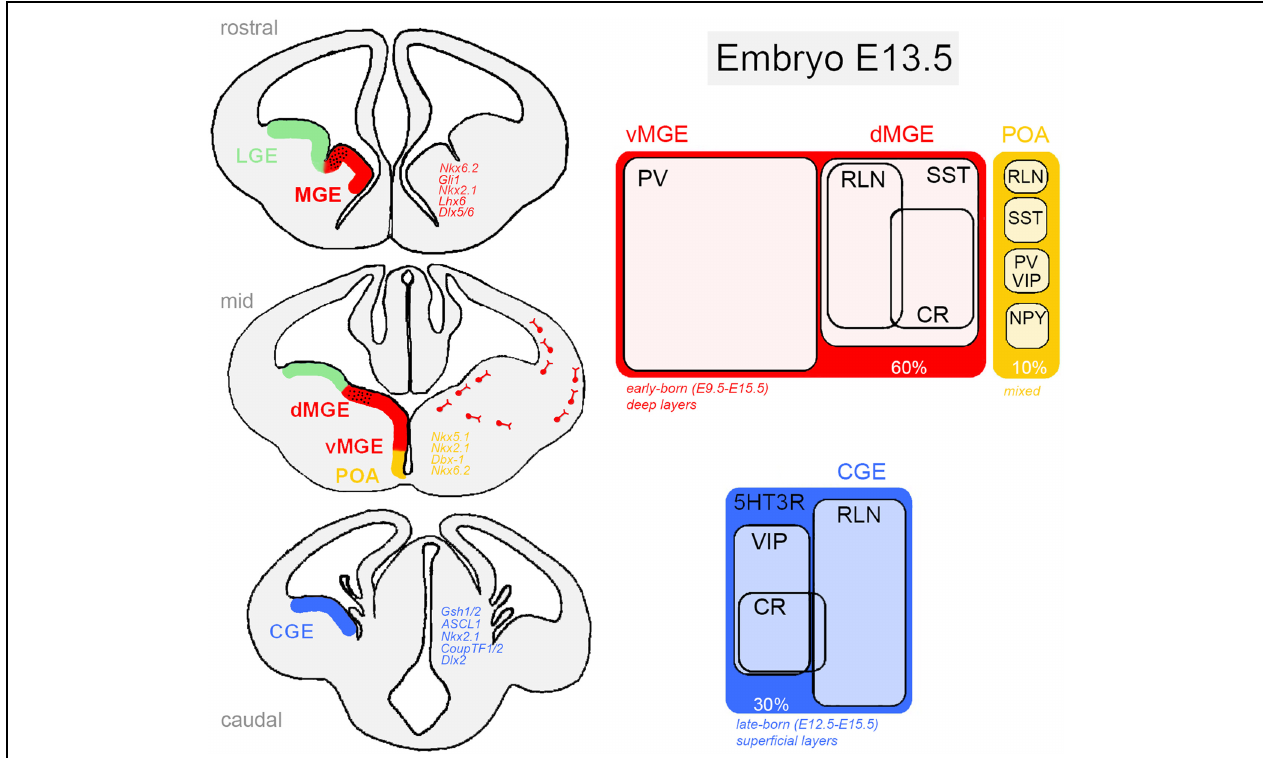
FIGURE 1 | Ventral telencephalic germinative zones of cortical GABAergic neurons in the rodent embryonic brain. The medial ganglionic eminence (dorsal, dMGE; ventral, vMGE), caudal ganglionic eminence (CGE), and the preoptic area (POA) are responsible for generating virtually all cortical interneurons. In each region, neural progenitor classes are defined by a combinatorial action of transcription factors (Left) that restrict cells to neurochemically defined fates (Right) . Distinct classes of inhibitory cells display characteristic morphology, laminar distribution and electrophysiological properties.